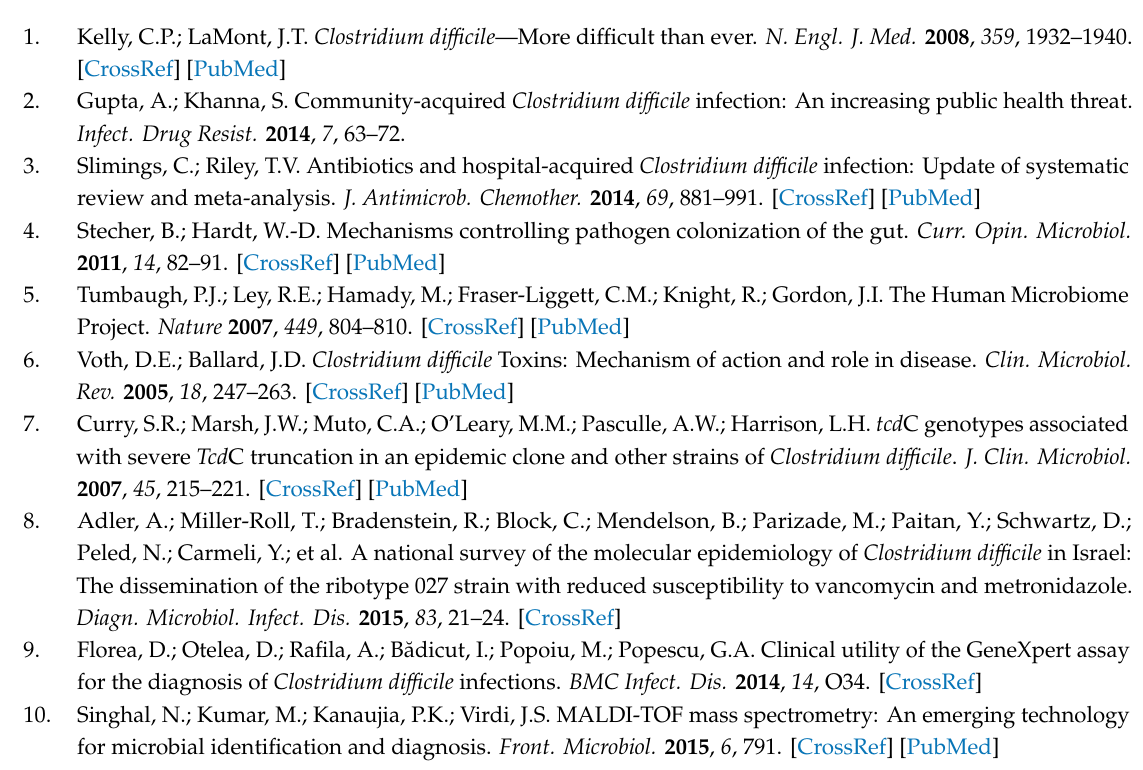
Table S1: Association between binary toxin gene presence and demographics